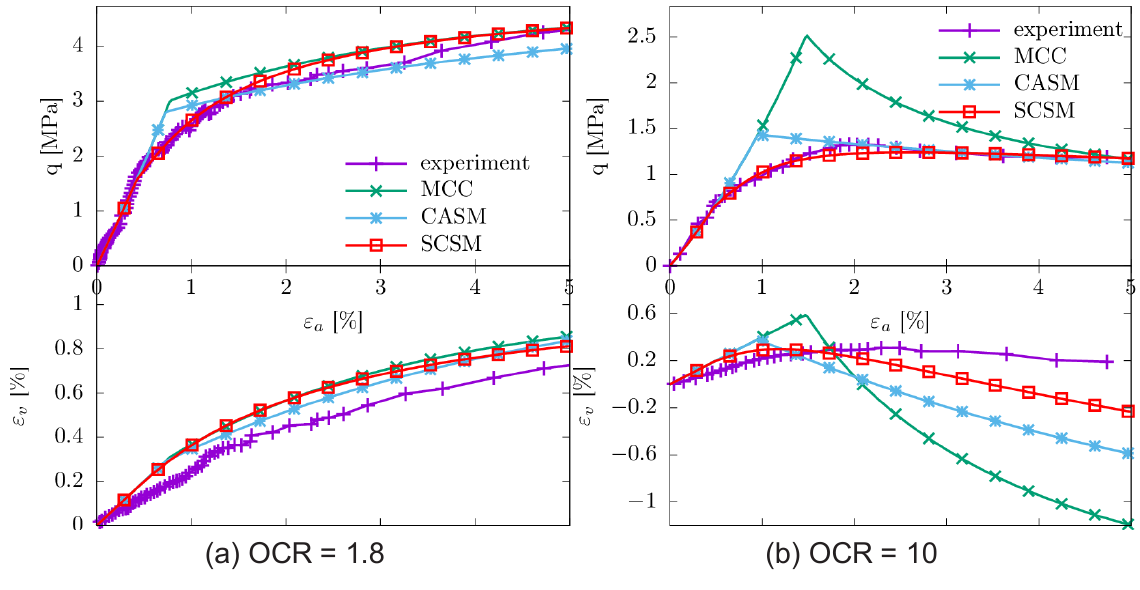
Figure 7: Simulation of drained compression of Boom clay for normally consolidated and overconsolidated states.